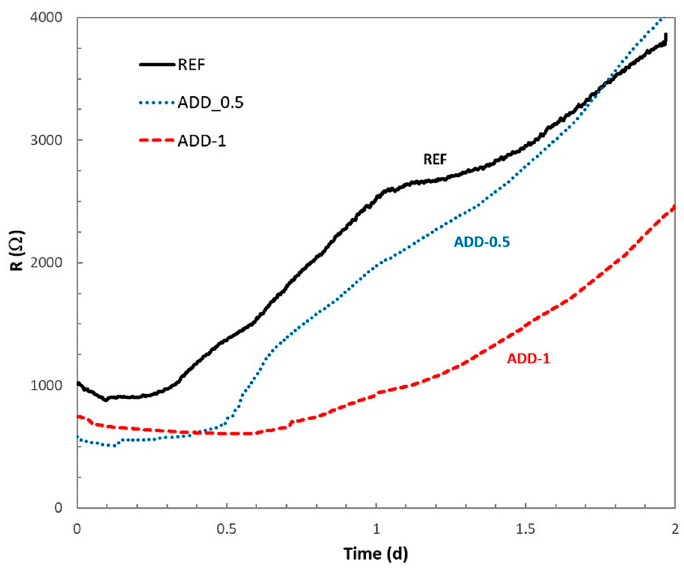
Figure 7. Evolution of the electrical resistance of the different mortars during the first 2 days curing in chamber at 98% relative humidity.